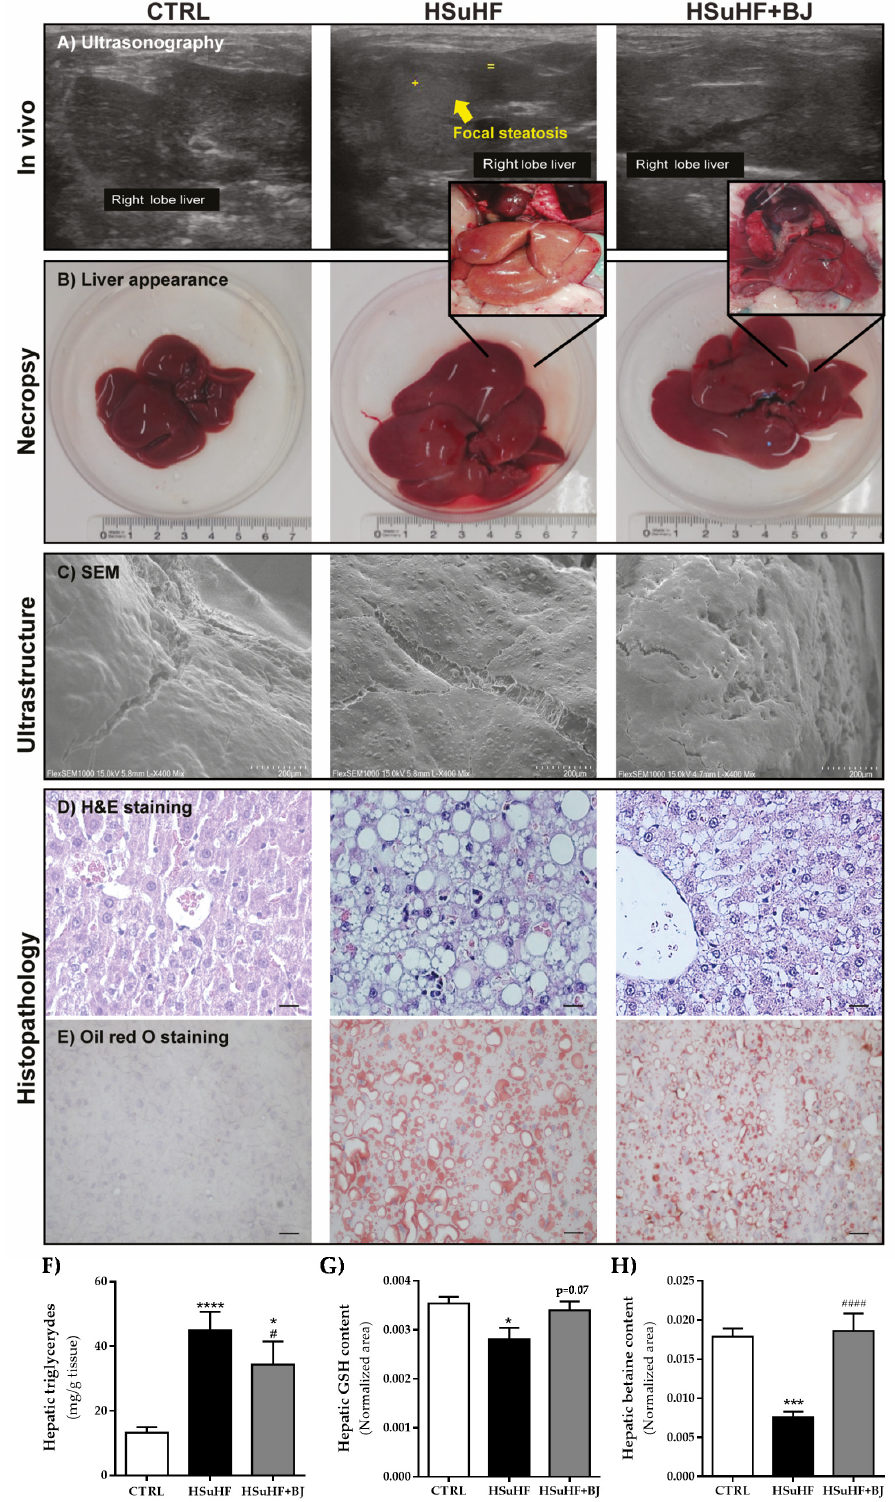
Figure 4. Impact of BJ on liver appearance and hepatic findings. Representative photographs of in vivo ultrasonography ( A ), macroscopic liver appearance during dissection and tissue collection ( B ), SEM images of rat liver tissue ( C ), and Hematoxylin–eosin and ( D ) Oil Red O staining ( E ) of liver sections from representative rats from each group ( × 400 magnification; scale bar = 20 µ m); hepatic triglycerides contents ( F ); hepatic GSH ( G ) and betaine contents ( H ) per group. Results are expressed as the mean ± SEM. * p < 0.05, *** p < 0.00,1, and **** p < 0.0001 vs. CTRL group; # p < 0.05 and #### p < 0.0001 and p = 0.07 vs. HSuHF group. CTRL: control. HSuHF: high sucrose/high-fat. BJ: blueberry